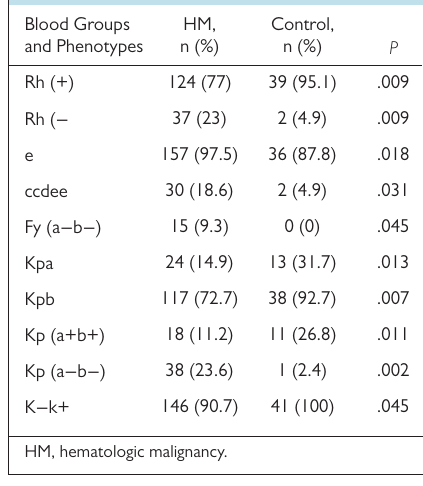
Table 2. Distribution of ABO, Kell, Duffy, Rh Blood Groups and Phenotypes in HM and Control Groups Blood Groups and